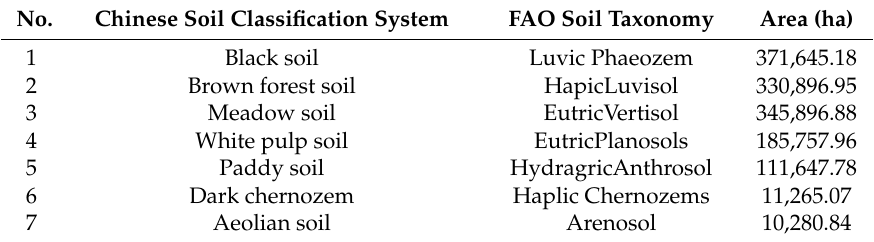
Table 1. Approximate correspondences of soil groups between Chinese soilclassification and Food and Agriculture Organization (FAO) reference soil